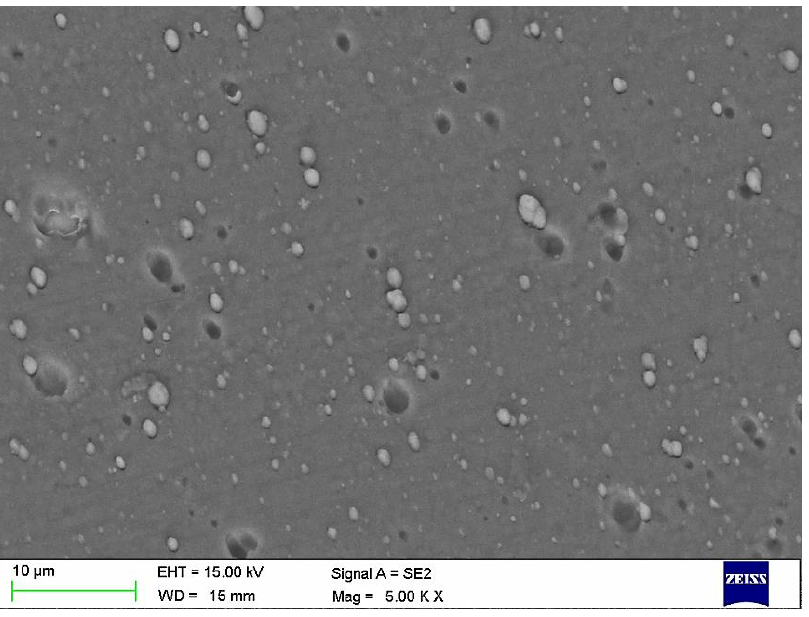
Figure 2. Topography of the (Ti,Al)N coating surface, deposited on the cemented carbide substrate.